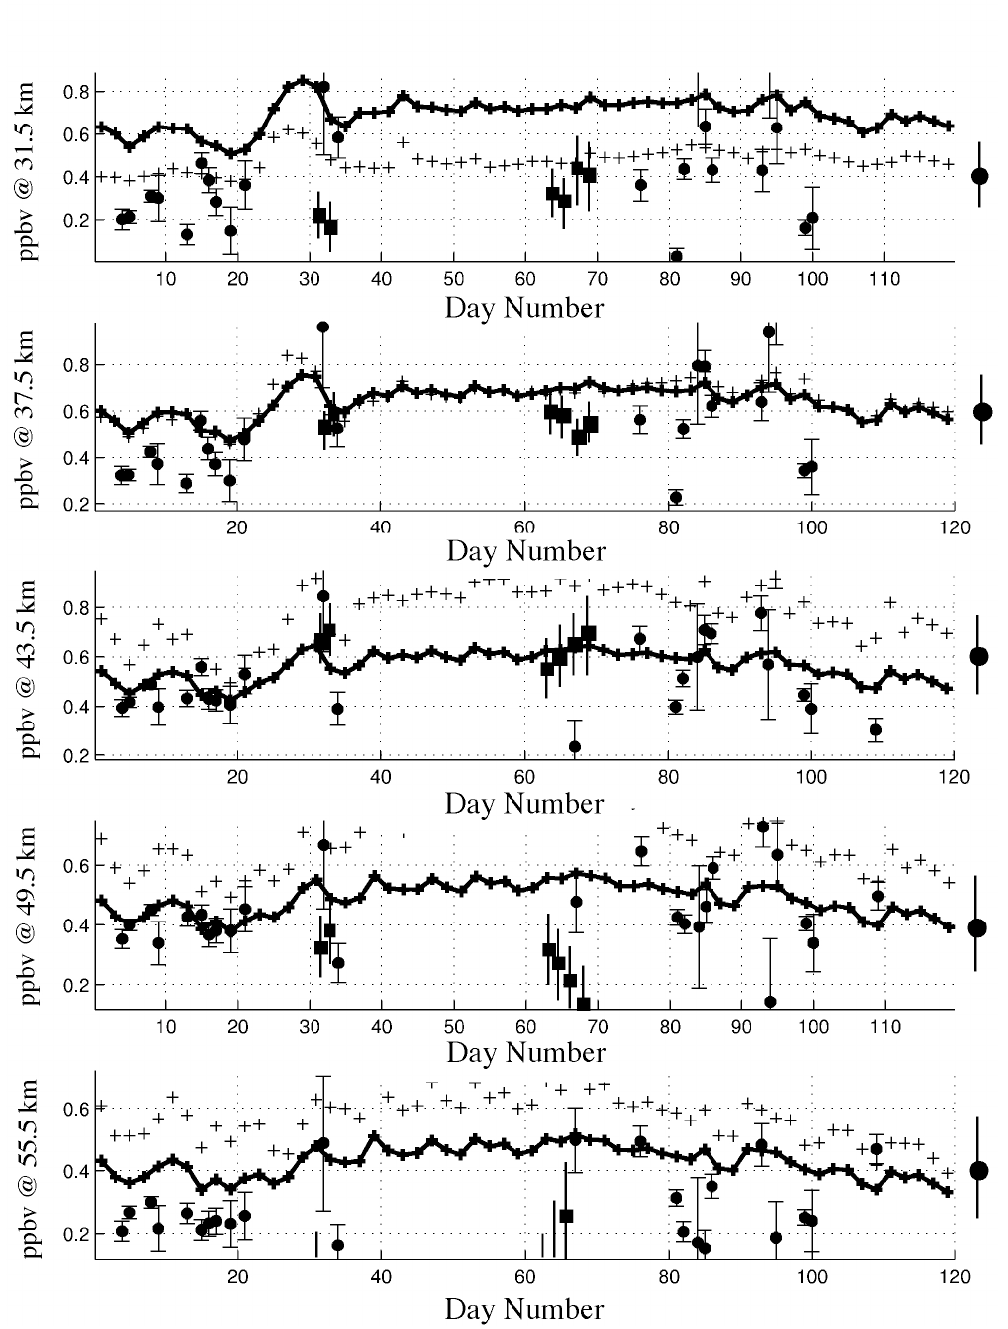
Fig. 13. Variations of daytime ClO VMR from January to April 1995 at 31.5, 37.5, 43.5, 49.5 and 55.5 km (from top to bottom), as retrieved from measurements by the radiometer installed at the Plateau de Bure (filled circles), as measured by the UARS/MLS instrument (squares), and as calculated by the 3-D CTM SLIMCAT model (thick crosses) within the same layers. Note that vertical resolution of the model and of the satellite data has been degraded to match the resolution of the ground-based measurements. For information, high resolution outputs from the 3-D model are also plotted (thin crosses). Only an uncorrelated 1- σ error due to the thermal noise is considered in the errorbar. Satellite data have been zonally-averaged within the latitude band 40 ◦ N–50 ◦ N, and only data measured between 11:00 LST and 15:00 LST have been considered as daytime measurements. A systematic 1- σ error for the Bure measurements (filled circle and thick line) is represented on the right-hand side of each